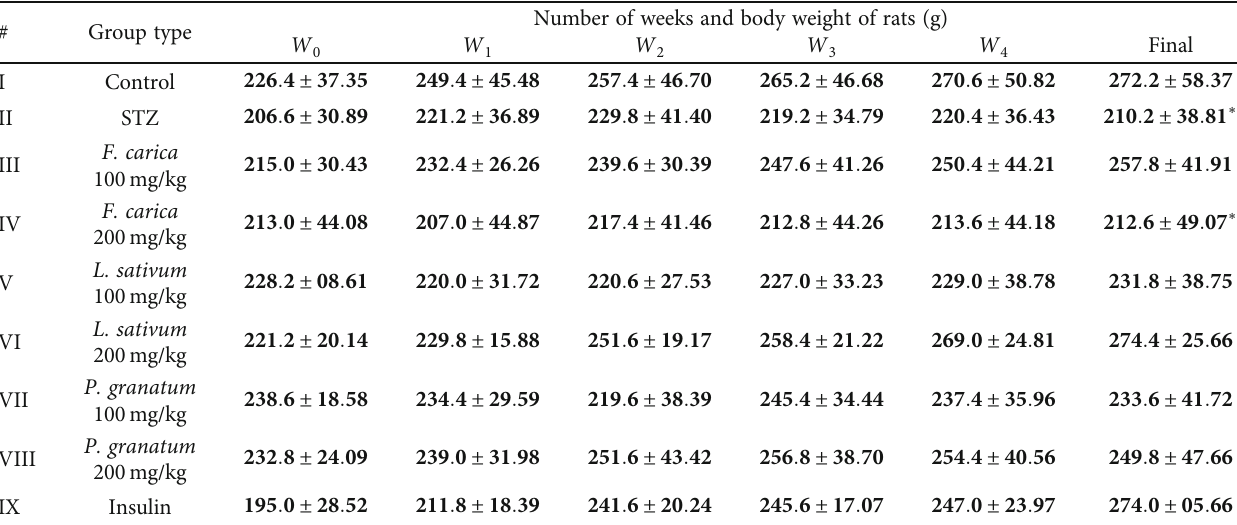
Table 2: E ff ect of di ff erent Lepidium sativum , Ficus carica , and Punica granatum methanolic extracts on 5-week body mass, in STZ-induced diabetic rats. Group